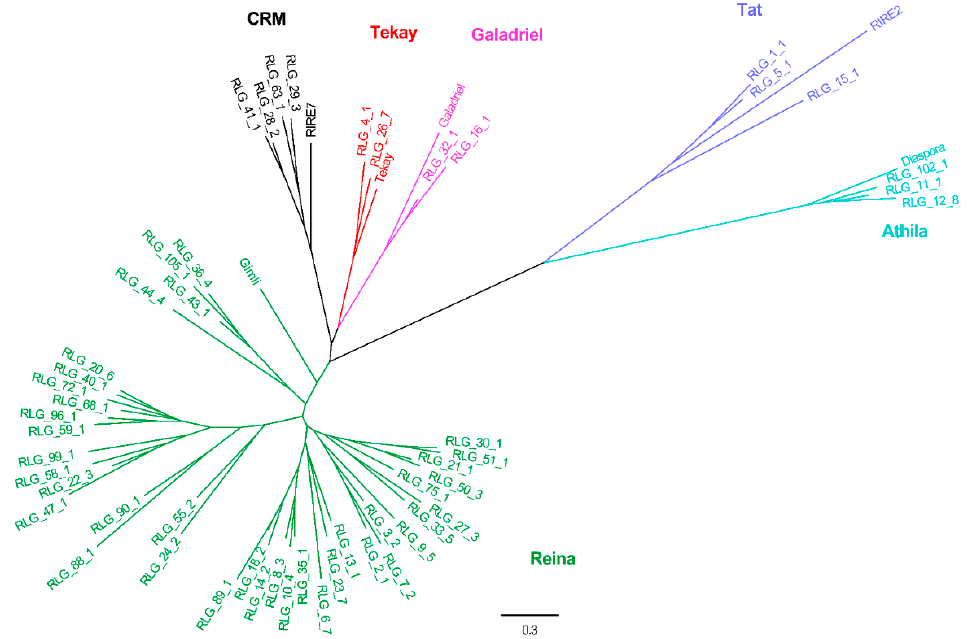
Figure 4. RT phylogenetic tree of Gypsy and representative members of the Gypsy lineages. Maximum-likelihood tree with representative RT sequences of each family and the representative members of the Gypsy lineages. In the tree, each family is marked by its name. Representative sequences that were reported in previous studies were selected. Nucleotide sequences of RT of individual families were aligned by MUSCLE (v.3.8.31). After best-fit models were evaluated by MEGA6, these sequences were used to construct the phylogenetic trees based on the maximum-likelihood method. The entire lineages are shown with different colors: Red, Tekay; Black, CRM; Green, Reina; Navy blue, Athila; Sapphire, Tat; and Purple, Galadriel. Locus name of representative members of the Gypsy lineages in Repbase (https://www.girinst.org/): Gimli, RIRE7, Galadriel, RIRE2, Diaspora, and Tekay. Genes 2019 , 10 , x FOR PEER REVIEW